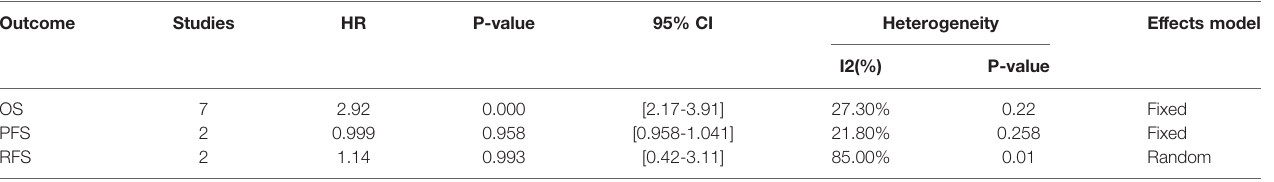
TABLE 3 | Summary of the meta-analysis of Ki-67 expression and OS, PFS, RFS. Outcome